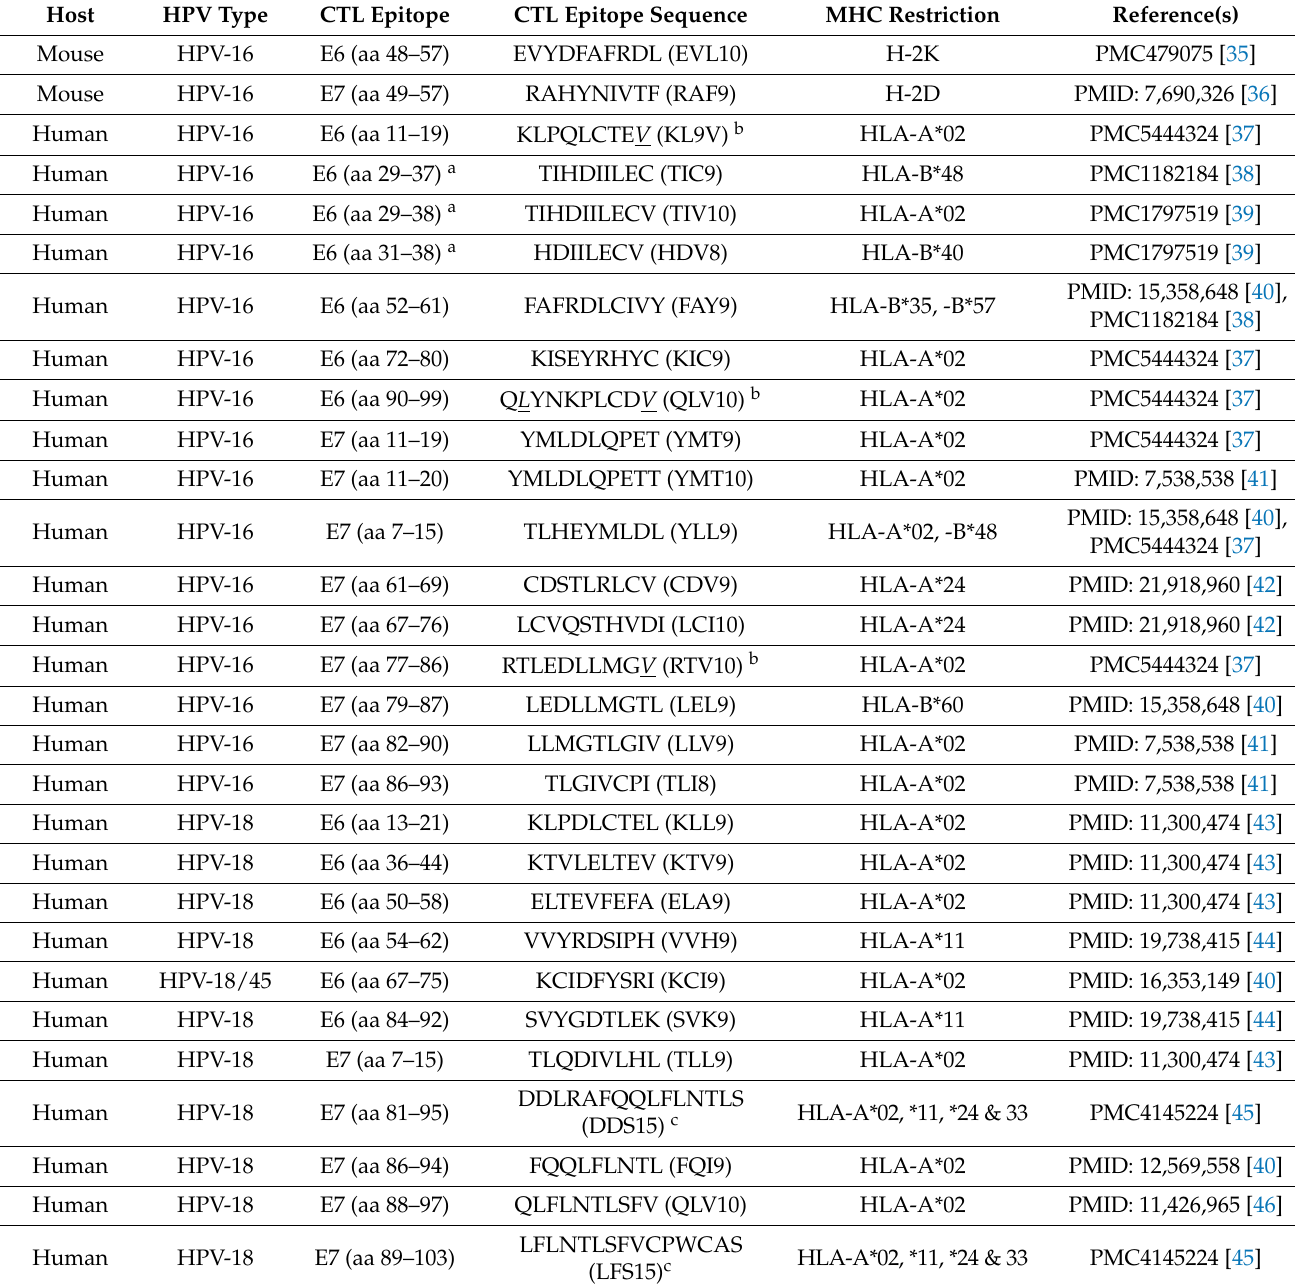
Table 1. Oncogenic HPV-derived epitopes that are known to induce or enhance cytotoxic T- lymphocyte (CTL) responses in preclinical and clinical